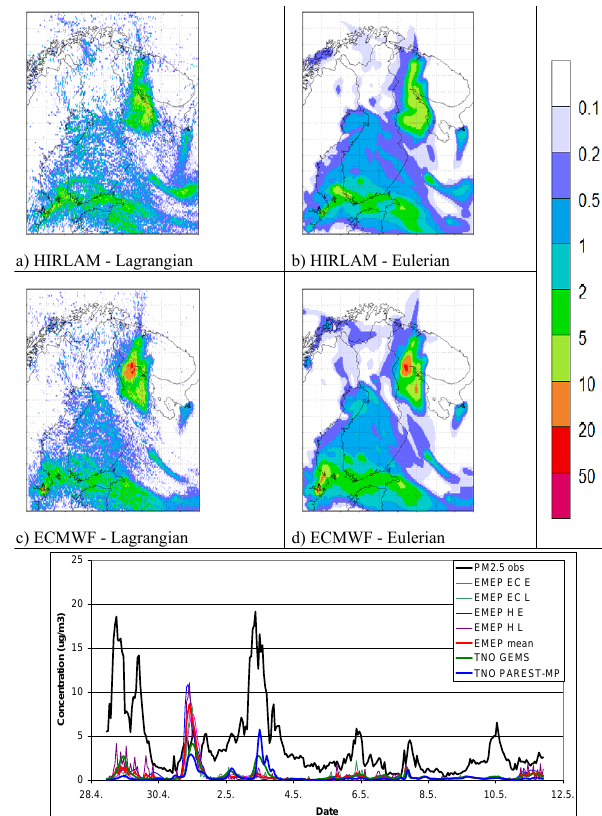
Figure 5. Surface-level concentrations of PM2.5, 0:00 at May 3, 2003, calculated using the Fig. 5. Surface-level concentrations of PM 2 . 5 , 00:00 at 3 May 2003, original EMEP emissions. Panels present the 4 members of the ensemble: a) Lagrangian calculated using the original EMEP emissions. Panels present the SILAM, HIRLAM meteo, b) Eulerian SILAM, HIRLAM meteo, c) Lagrangian SILAM, ECMWF meteo, d) Eulerian SILAM, ECMWF meteo, e) time series for all four computations 4 members of the ensemble: (a) Lagrangian SILAM, HIRLAM me- plus Eulerian SILAM with TNO-GEMS and PAREST-MEGAPOLI emissions and ECMWF teo, (b) Eulerian SILAM, HIRLAM meteo, (c) Lagrangian SILAM, meteorology, and Varrio PM2.5 observations. ECMWF meteo, (d) Eulerian SILAM, ECMWF meteo, (e) time series for all four computations plus Eulerian SILAM with TNO- GEMS and PAREST-MEGAPOLI emissions and ECMWF meteo- rology, and Varrio PM 2 . 5